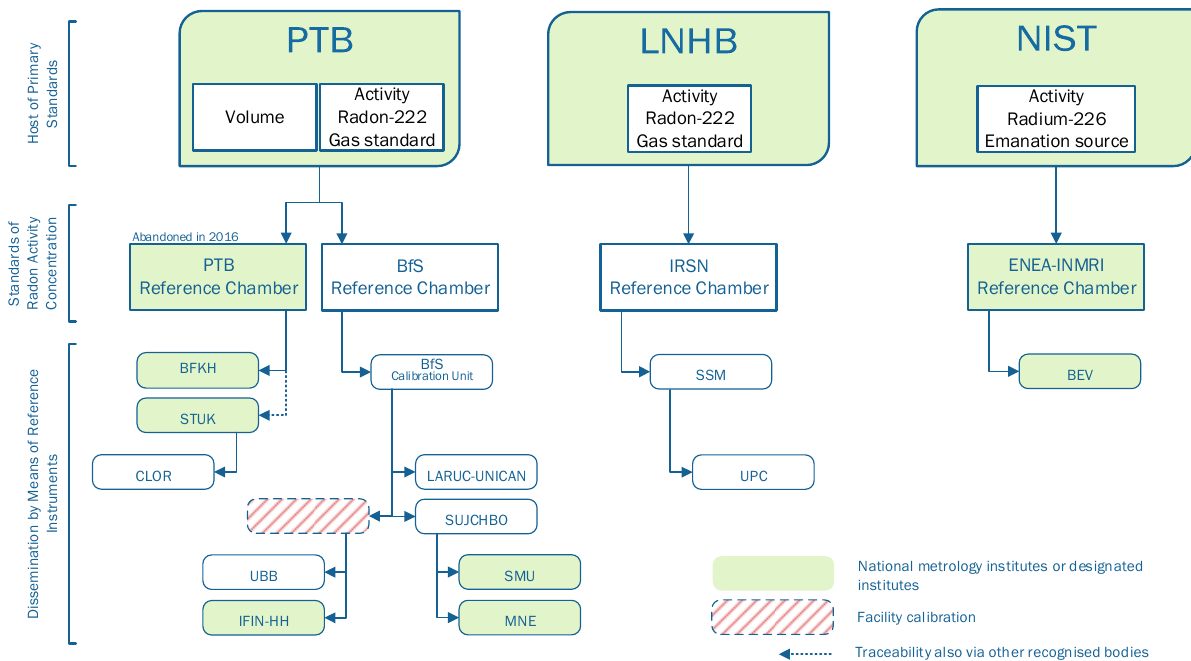
Figure 4. Chart of metrological traceability of European calibration facilities for radon: status at the start of the interlaboratory comparison (2018).